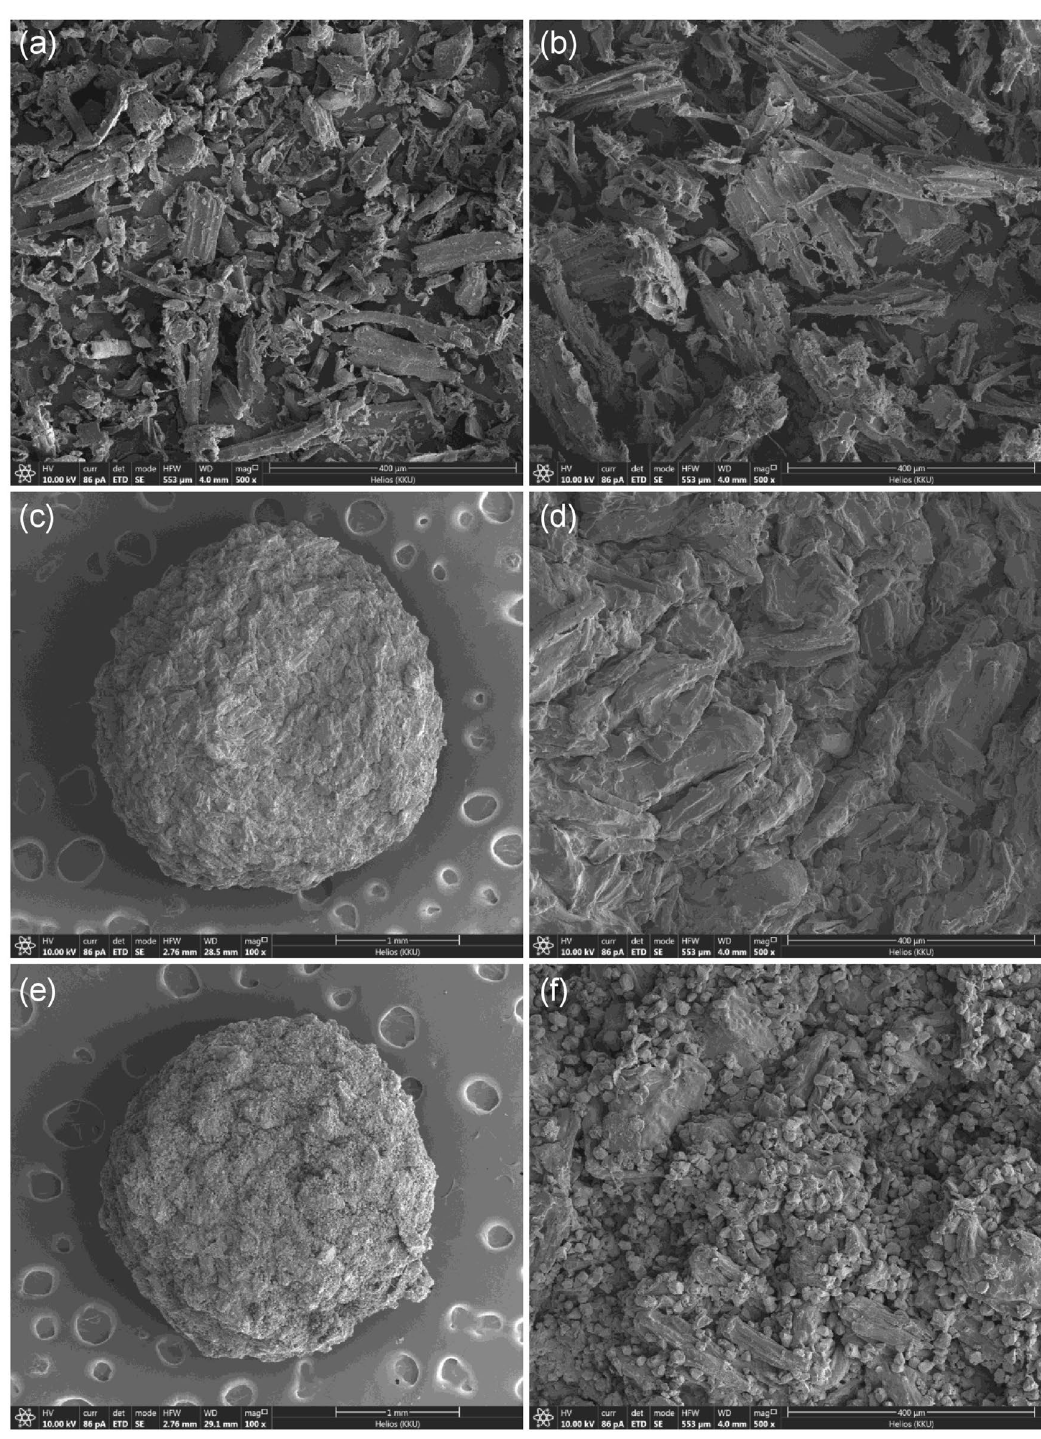
Figure 2. The surface morphologies of ( a ) sawdust powder (SP), ( b ) sawdust powder doped iron (III) oxide- hydroxide (SPF), ( c , d ) sawdust beads (SPB), and ( e , f ) sawdust powder doped iron (III) oxide-hydroxide beads